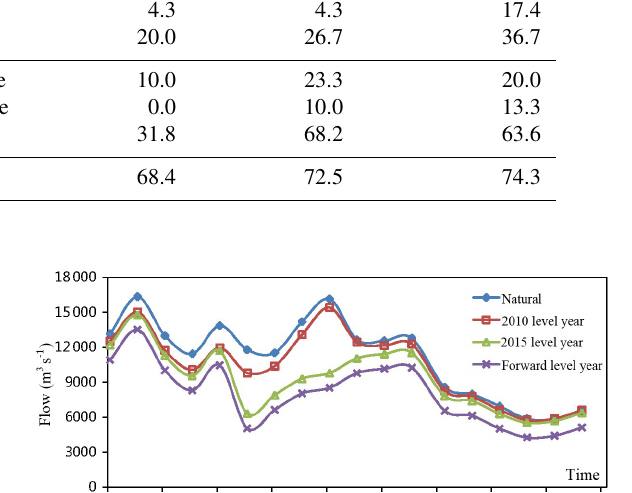
ward level year were 68.4 72.5 and 74.3 % respectively, all belonging to high alteration in the three level